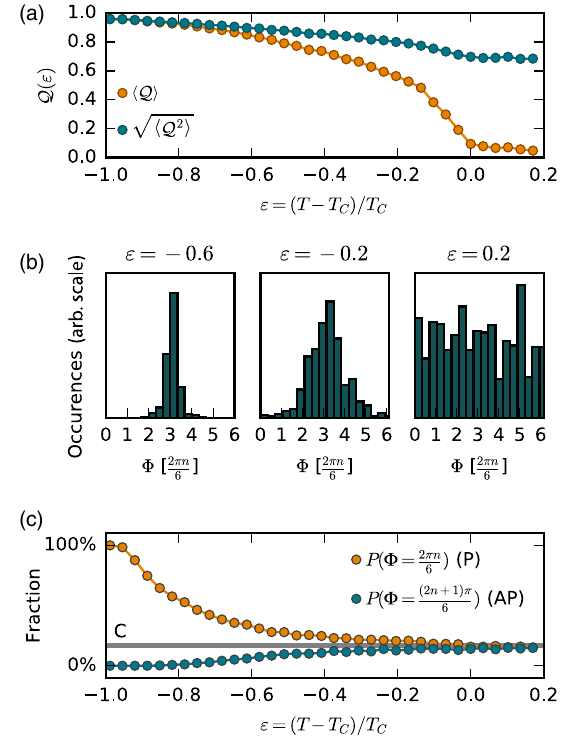
FIG. 6. Monte Carlo simulations of the effective Hamiltonian using the DFT parameters as described in the text. (a) Local order- ffiffiffiffiffiffiffiffiffiffi p parameter amplitude and its macroscopic expectationvalue h Q 2 i h Q i , as a function of reduced temperature. Note that the local order , whereas its macroscopic parameter does not go to zero above T C expectation value vanishes above T due to the disordering of the C order-parameter angle. (b) Histograms of the order parameter angle at a temperature well below T (left), just below T (center), and C C above T (right). We see that the angle is well defined at low C temperatures, broadens upon heating, and can have any value above T . (c) Probability P that the states in the minima ( Φ ¼ ½ð 2 π n Þ = 6 (cid:2) ) C (brown circles) and the maxima ( Φ ¼ f½ð 2 n þ 1 Þ π (cid:2) = 6 g ) (green circles) within the brim of the hat are occupied. At low T , only the minima are occupied [ P f Φ ¼ ½ð 2 π n Þ = 6 (cid:2)g ¼ 100% ], but at higher temperatures, the fractions converge towards the continuous limit marked by the line denoted “ C, ” which corresponds to an equal distribution between all angles. The probabilities were extracted by creating 36 bins in ½ 0 ; 2 π (cid:2) , and as a result, C has a 16.7% ffiffiffiffiffiffiffiffiffiffi is reduced by only around 20%, while its macroscopic expectation value h Q i goes to zero [Fig. 6(a)].